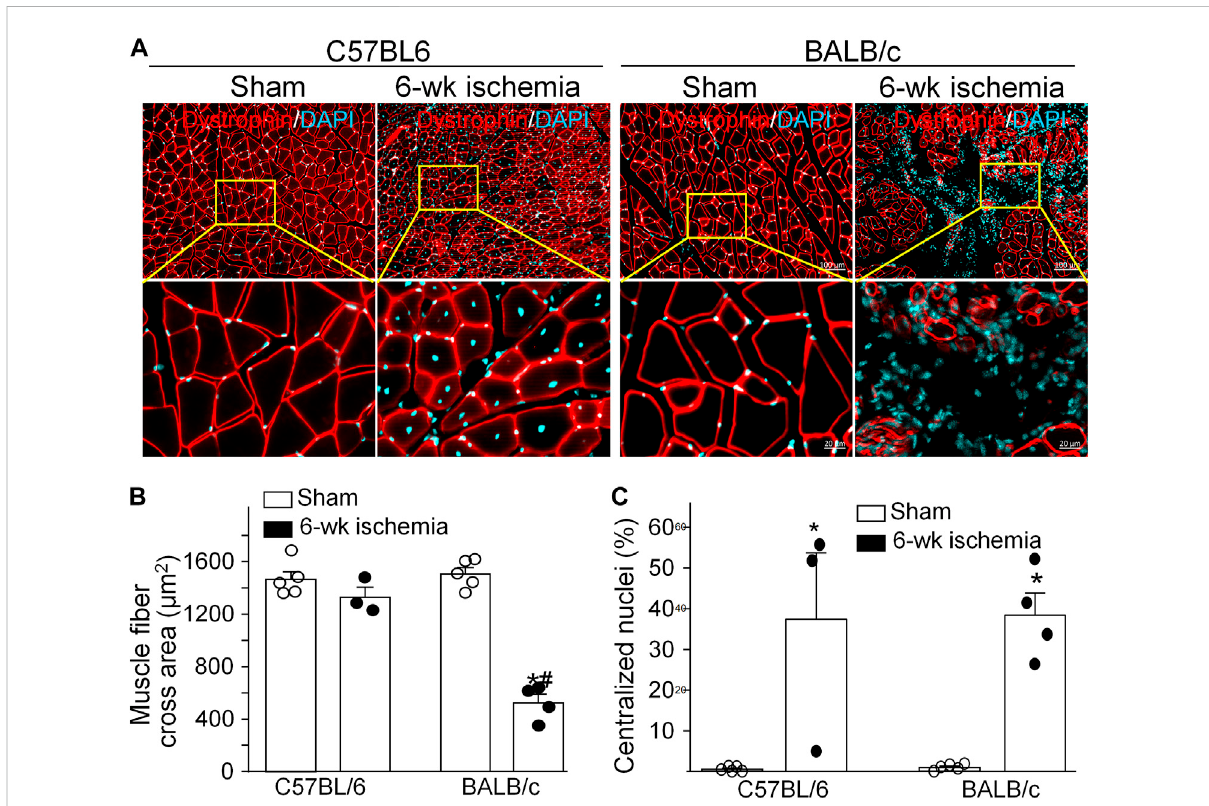
FIGURE 2 Structural changes of gastrocnemius muscles induced by 6 weeks of the femoral artery ligation (Isch) in C57BL/6 and BALB/c mice. (A) , representative immuno fl uorescence images of cross muscle section with dystrophin staining. (B) and (C) , summary data for cross sectional area of muscle fi bers and the percentage of myo fi bers with centralized nuclei in gastrocnemius muscles. Data are mean ± SEM, n = 5, 3, 5, and 4 mice in C57BL/6 sham, C57BL/6 Isch, BALB/c sham, and BALB/c Isch group, respectively. * p < 0.05 vs. C57BL/6 sham or BALB/c sham, respectively; # p < 0.05 vs. C57BL/6